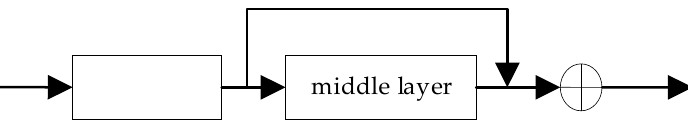
Figure 2. Diagram of a residual network unit.